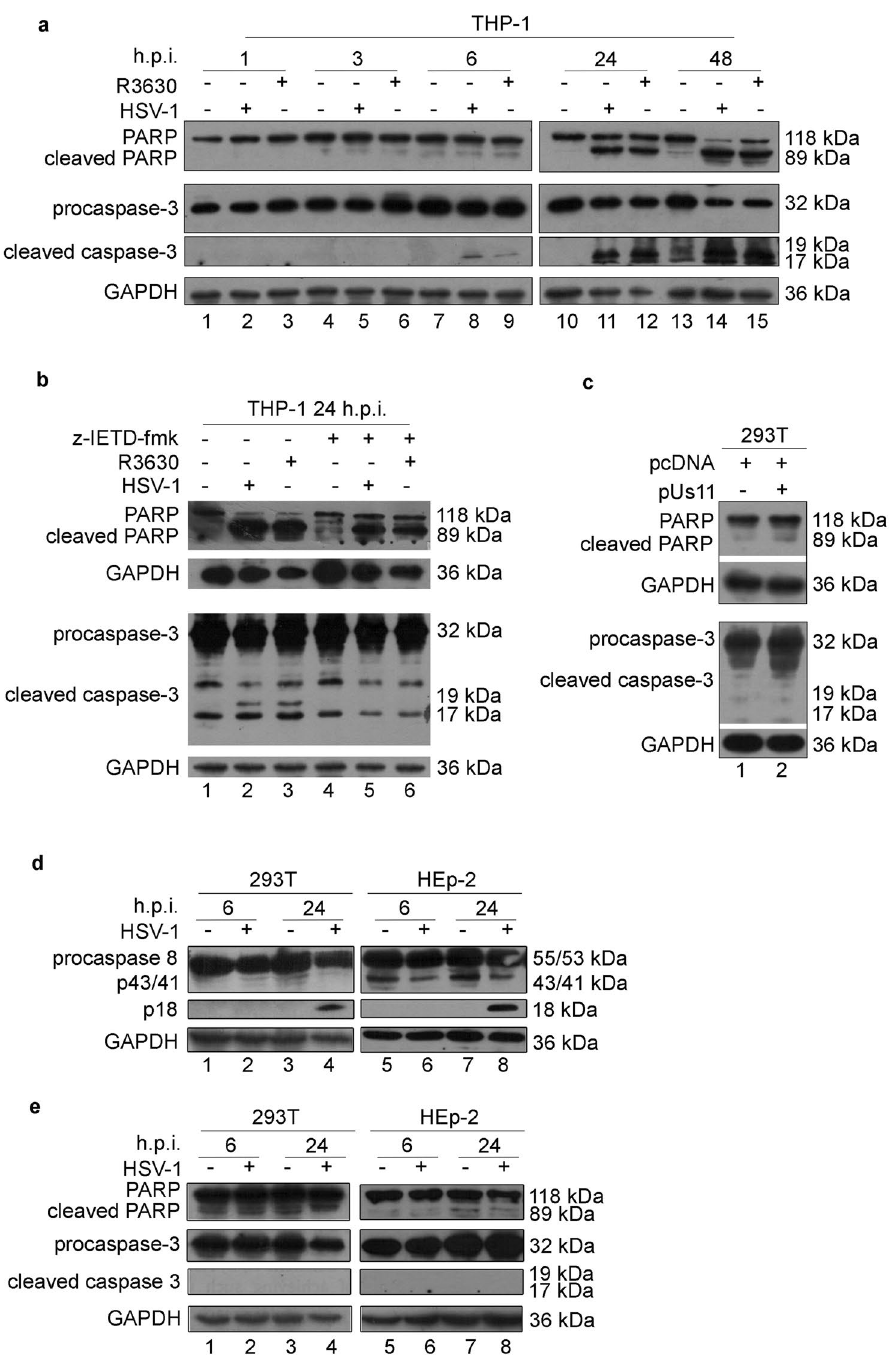
Figure 3. Analysis of apoptotic markers. Western blot analysis of PARP and caspase-3 from: ( a ) THP-1 cells infected with HSV-1 or R3630 (ΔUs11/Us12) and collected at 1,3,6,24 and 48 h.p.i; The grouping blots are cropped from two different simultaneously exposed gels. ( b ) THP-1 cells infected with HSV-1 or R3630 (ΔUs11/ Us12) and treated or not with the caspase-8 inhibitor z-IETD-fmk (100 µM); ( c ) THP-1 cells transfected with pUs11 and collected 72 h post transfection. The membranes were probed with an antibody directed to caspase-3 and PARP. GAPDH was used as a loading control; The grouping blots are cropped from two different gels as reported in supplementary file 3 (Fig. S3) ( d ) and ( e ) analysis of caspase-8 and apoptosis marker in non- immune cells (293 T and HEp-2) infected or not with HSV-1. To improve the clarity and conciseness of the presentation, the figures were presented as cropping parts of the same gel (Fig. S3). The membranes were probed with antibodies directed to caspase-8, caspase-3 and PARP. GAPDH was used as a loading